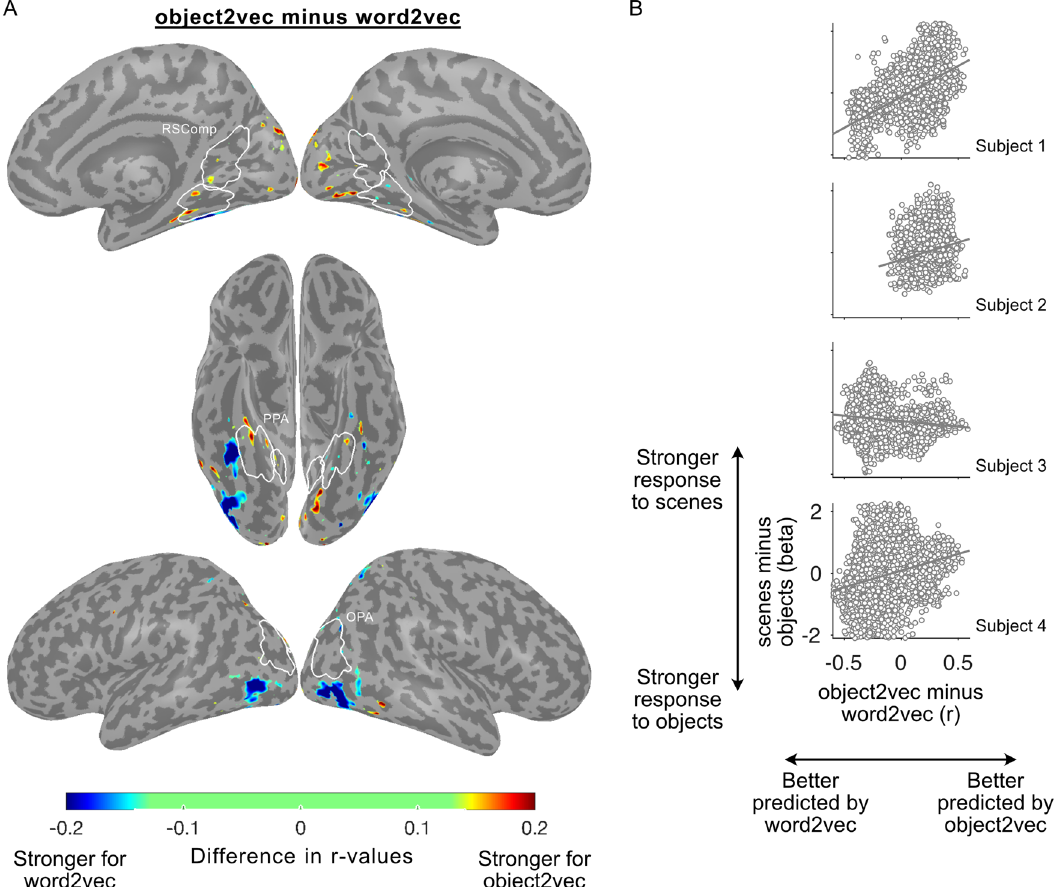
Fig. 7 Whole-brain voxel-wise preference map for visual vs. linguistic context and relationship to category selectivity. A This preference map shows differences in model performance for the object2vec (visual context) encoding model and the word2vec (linguistic context) encoding model. Voxel-wise difference scores were calculated by subtracting prediction accuracy for the word2vec model from prediction accuracy for the object2vec model. Warm colors indicate voxels that were better explained by object2vec and cool colors indicate voxels that were better explained by word2vec. Difference scores are plotted for voxels that show a signi fi cant preference for either model ( p < 0.05, FDR-corrected, one-sided permutation test). There are clusters of signi fi cantly greater prediction accuracy for object2vec relative to word2vec overlapping with anterior PPA, mostly in the right hemisphere. There are clusters of signi fi cantly greater prediction accuracy for word2vec relative to object2vec in regions lateral to the PPA, extending to the lateral occipital cortex. ROI parcels are shown for scene-selective ROIs. PPA parahippocampal place area, OPA occipital place area, RSComp retrosplenial complex. B Category selectivity of individual voxels is plotted as a function of their encoding-model preferences. For each subject, all voxels with signi fi cant effects for either the image-based object2vec encoding model or the language-based word2vec encoding model are plotted. The x axis plots the difference in prediction accuracy between the object2vec encoding model and the word2vec encoding model. The y axis plots the difference in activation between scenes and objects, based on data from a separate set of functional localizer runs. Positive linear trends suggest that voxels that are better predicted by object2vec than word2vec tend to be more scene-selective and voxels that are better predicted by word2vec than object2vec tend to be more object- selective (Pearson r values = 0.51, 0.20, − 0.17, 0.29 for subjects 1 – 4). Source data are provided as a Source Data fi